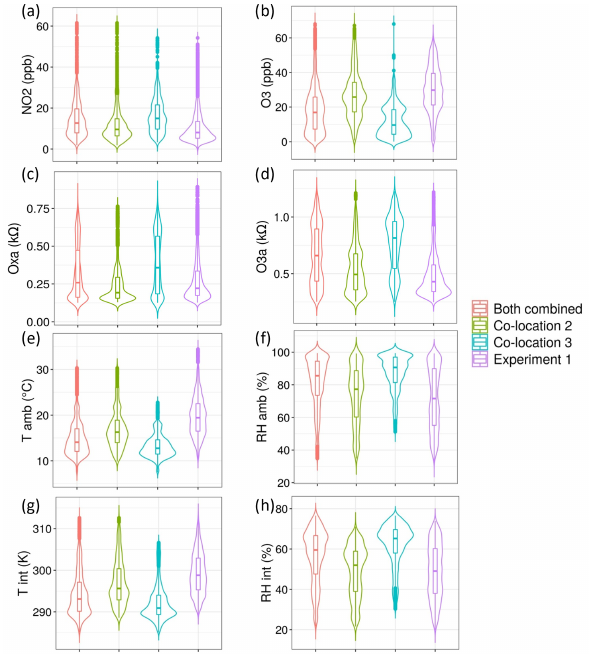
Figure 4. Violin plots of (a) reference NO 2 , (b) reference O 3 , (c) Oxa, (d) O3a, (e) T amb , (f) RH amb , (g) T int , and (h) RH int for co-location 2, co-location 3, both co-locations combined, and the experimental